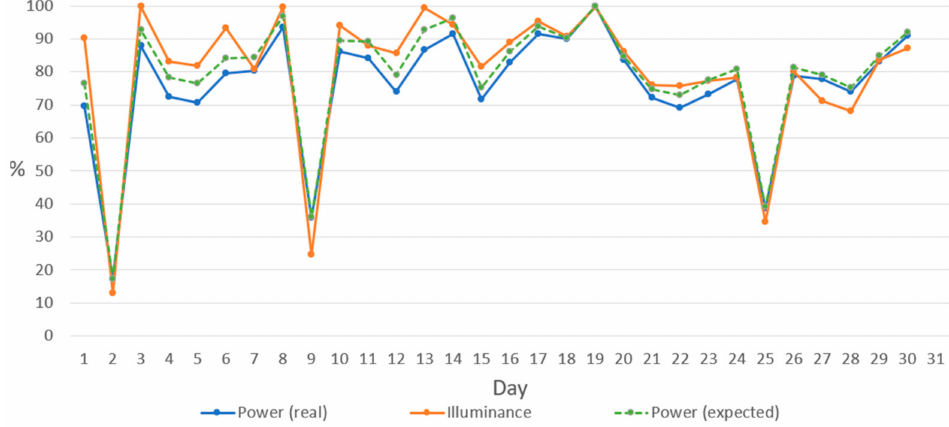
Figure 13. Percentage monthly distribution of light intensity and power. Power calculated from the relationship (1), expected at 25 ◦ C, is marked in